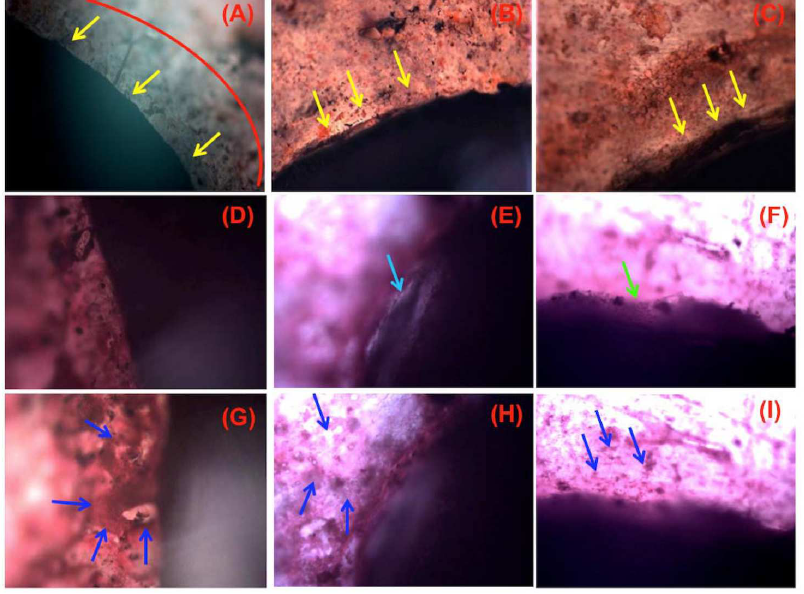
Fig 12. Undecalcified histological sections of peri-implant bone formation following osteointegration of different cortex screws in tibia. (A, D and G) SLAffinity, (B, E and H) commercialand (C, F and I) sand- blastedcortex screws. Red semicircleindicatesnew bone formation at interface betweenhost bone tissue and screw implant. Osteocyte formation is indicatedby yellow arrow. Light blue and green arrows indicate that a large gap is observedbetweenthe implantand host bone and some bony ongrowthhave enlargedthe contact interface with the trabecularbone, respectively. The newly bone formation in peri-implant tissues from different implants are indicatedby dark blue arrows. (H&E; A, B and C, originalmagnification X10; D-I, original magnification X20).